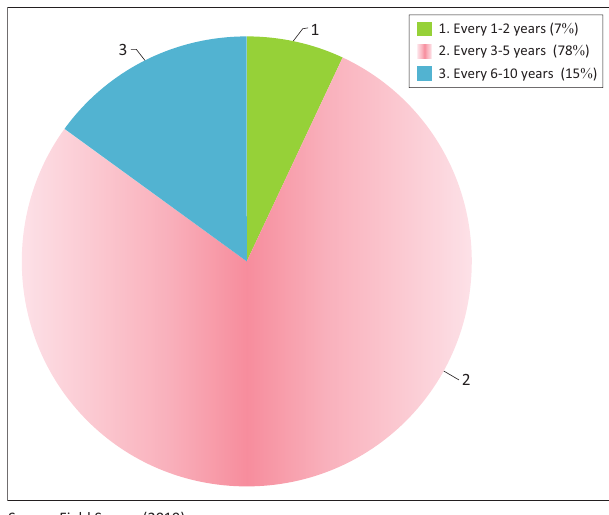
FIGURE 2: Perception of respondents on drought frequency.